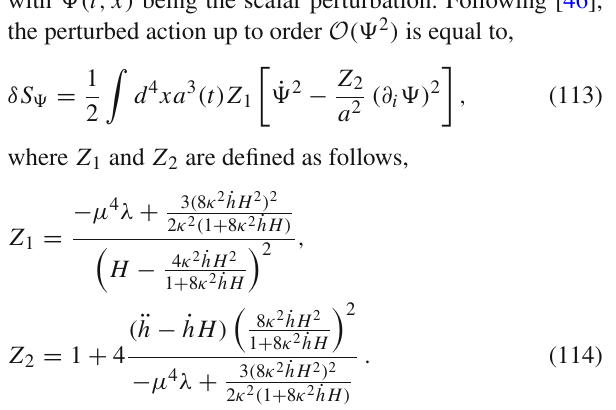
˙ hH Fig. 13 ¨ h vs. e -folding number for h and μ 2 /((cid:13) M ) = 0 .